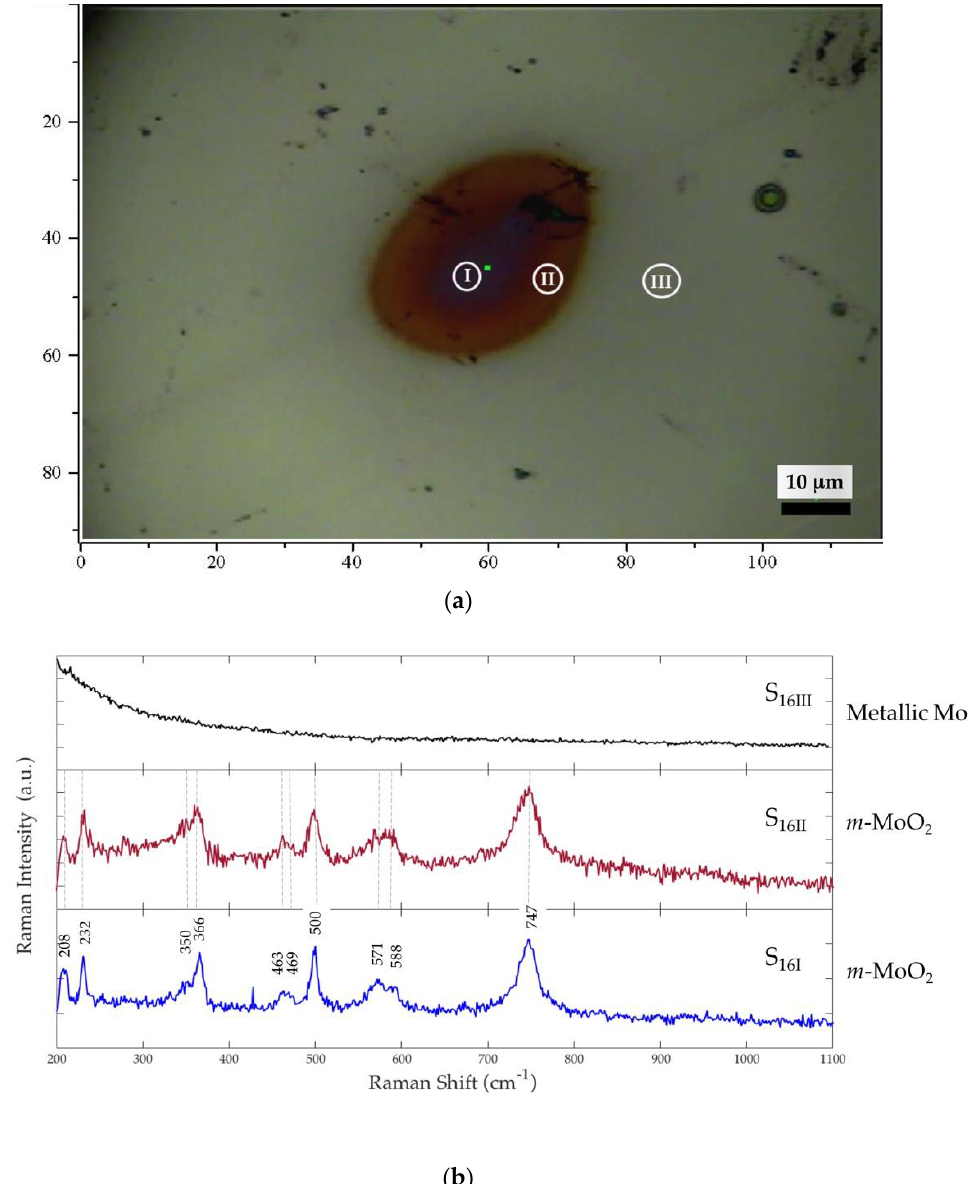
Figure 4. Optical micrograph ( a ) with I, II, III the positions where Raman measurements were taken, and spatially resolved Raman spectra ( b ) for the irradiated spot S 16 at per-pulse laser fluence 1.4 mJ/cm 2 and 3 min exposure time.